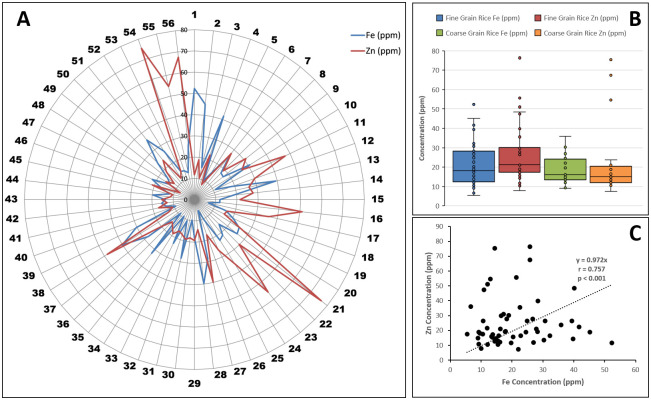
Grain Fe and Zn contents and correlation in studied rice accessions.(A) Grain Fe and Zn contents in studied rice accessions. Numbers outside the spider graph indicate serial numbers of the genotypes mentioned in S1 File. (B) Comparison between grain Fe and Zn contents in fine and coarse grain accessions. Each dot in box plots represents individual value. (C) Pearson correlation between Fe and Zn contents.